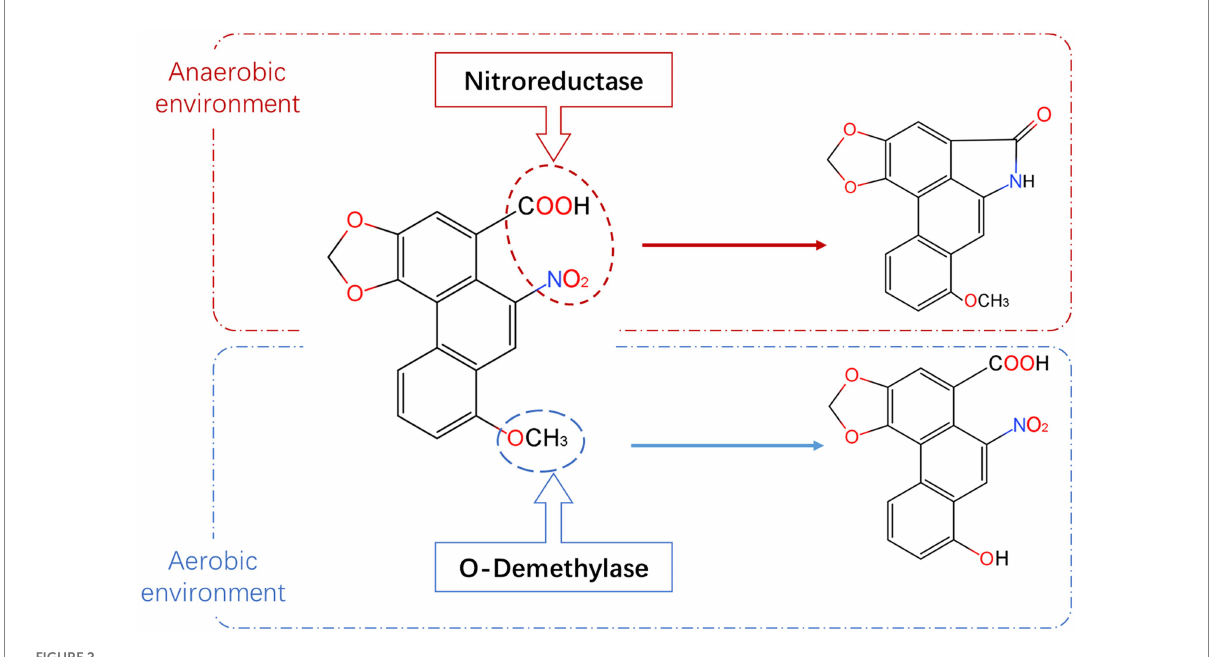
FIGURE 2 Degradation pathway and metabolites of AAI. The red dotted box represents the metabolic pathway and metabolites of AAI under anaerobic condition, and the blue box represents the metabolic pathway and metabolites of AAI under aerobic condition (information summarized and adapted from Pfau et al., 1990; Shibutani et al., 2010; Levová et al., 2011; Stiborová et al., 2015 Chang et al., 2017; Anger et al.,